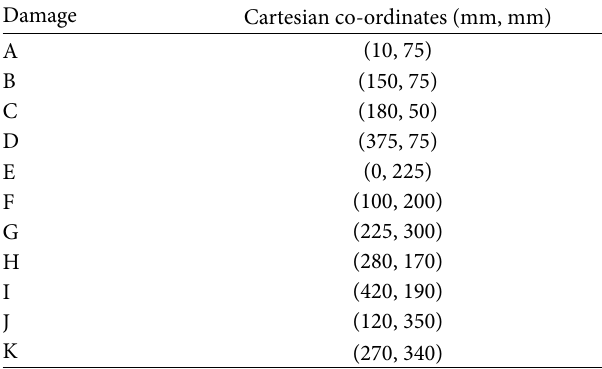
Table 1: Positions of the simulated